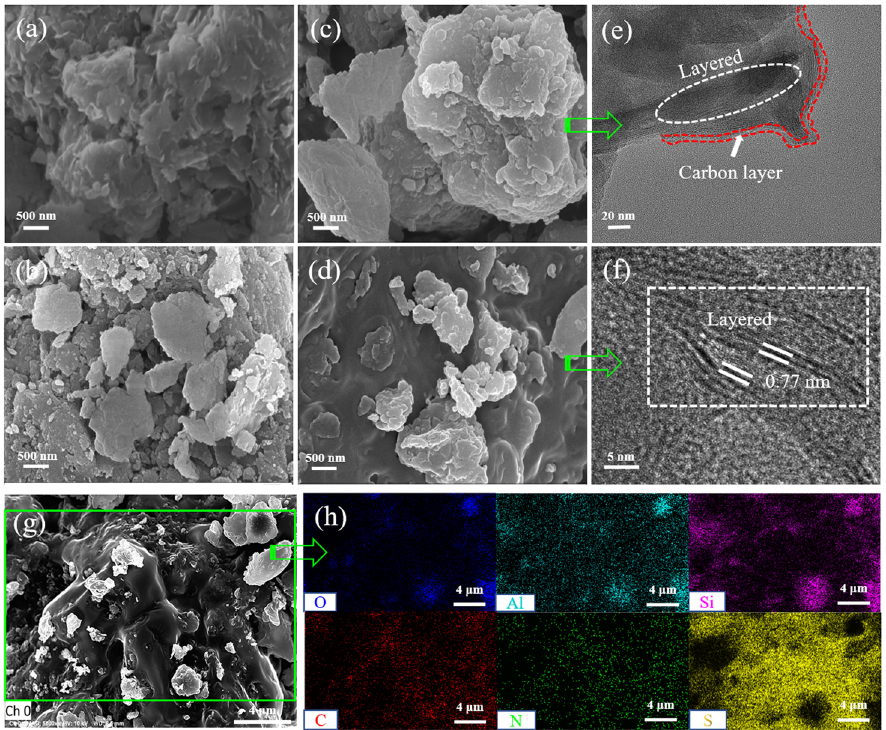
Figure 2: SEM images of Raw - Bent ( a ) , Al/CS - Bent ( b ) , Bent@C ( c ) , S/Bent@C ( d ) , and corresponding elemental mapping images of O, Al, Si, C, N, and S ( g and h ) . TEM images of Bent@C ( e ) and S/Bent@C ( f ) .